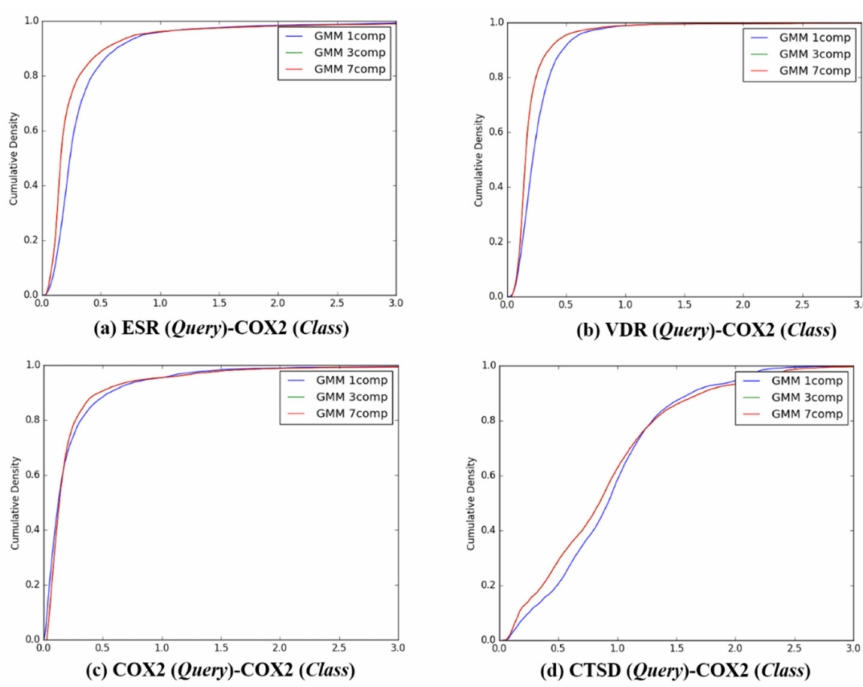
Figure 6. The cumulative densities of K–L distance between Q -distribution (Target class: COX2) and queries. X -axis: K–L divergence, Y -axis: cumulative density; Q -distribution of COX2 through GMM and the distribution of queries were calculated. ( a ) ESR(Query)-COX2(Class), ( b ) VDR(Query)-COX2(Class), ( c ) COX2(Query)-COX2(Class), and ( d )